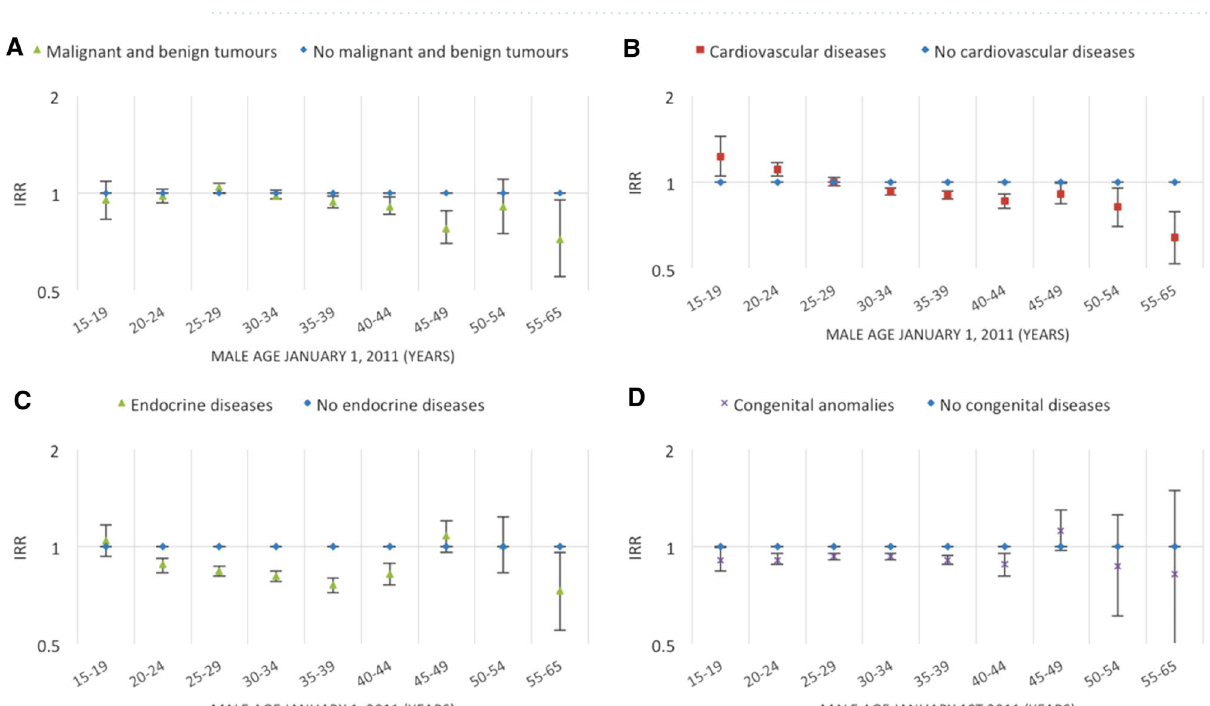
Figure 7. Incidence rate ratios (IRR) of fathering a child according to selected somatic diseases 1 and age 2 . Men aged 15–65 years living in Denmark January 1, 2011 to December 31, 2015. 1 Somatic diseases (diagnosed before January 1, 2011) included malignant and benign tumours, cardiovascular diseases, endocrine diseases, or congenital anomalies. 2 Age groups according to the man’s age by January 1,